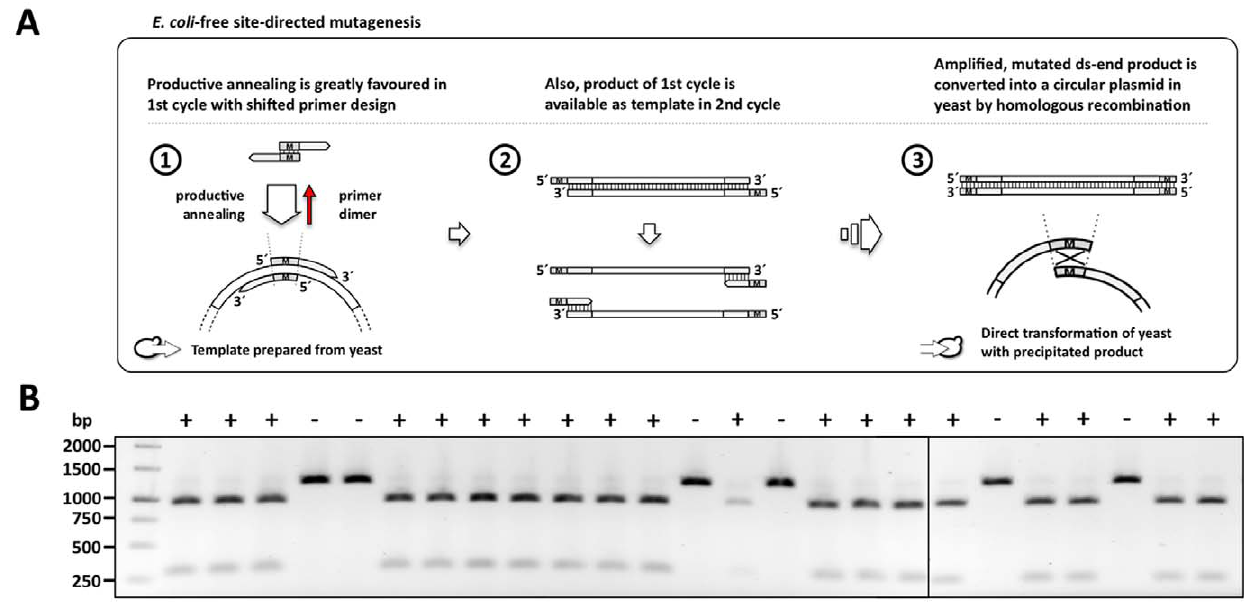
Figure 2. The DREAM method allows site-directed mutagenesis of an unstable BSEP -carrying plasmid without the need for E.coli . A, The product yield can be increased significantly by shifting the primer binding sites from a complete to a partial overlap that allows binding of the primers to product in subsequent cycles. The minute amount (10 ng) of non-mutated template used in the reaction is easily outnumbered by the yield of mutagenesis product, which is double-stranded (ds) due to the modified primer design (see also Figure S2). This allows for the direct transformation of S. cerevisiae without the need of prior template removal. The mutagenesis product is then recircularized by homologous recombination of the double-stranded ends. B, Analysis of S. cerevisisae transformants obtained from the modified SDM protocol shows a high mutagenesis efficiency. Successful mutagenesis in this case results in the addition of an Bst BI restriction site into the BSEP coding sequence. Colony PCR of the resulting transformants was performed with primers surrounding the mutagenesis site, and the resulting product was digested with Bst BI. 19 of the 25 tested clones carried the additional restriction site ( + ), corresponding to a mutagenesis efficiency of 76%.